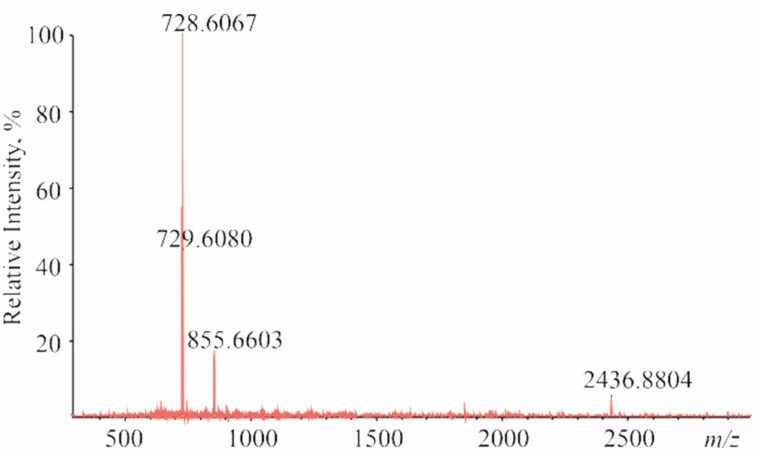
Figure 5. The MALDI-TOF mass spectrum of (PyC 60 ) 2